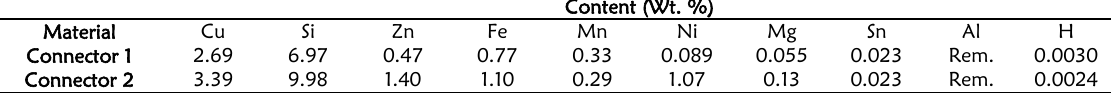
Table 2: Chemical composition of failed connector materials Content (Wt.